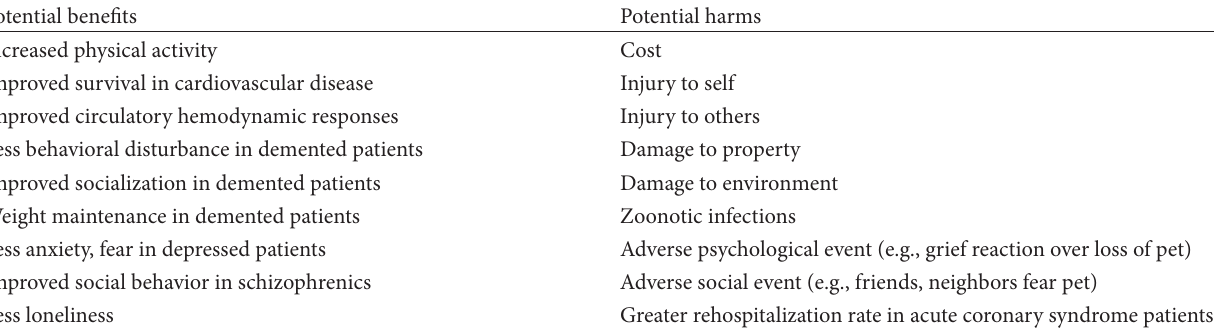
Table 5: Potential benefits and risks of animals in the